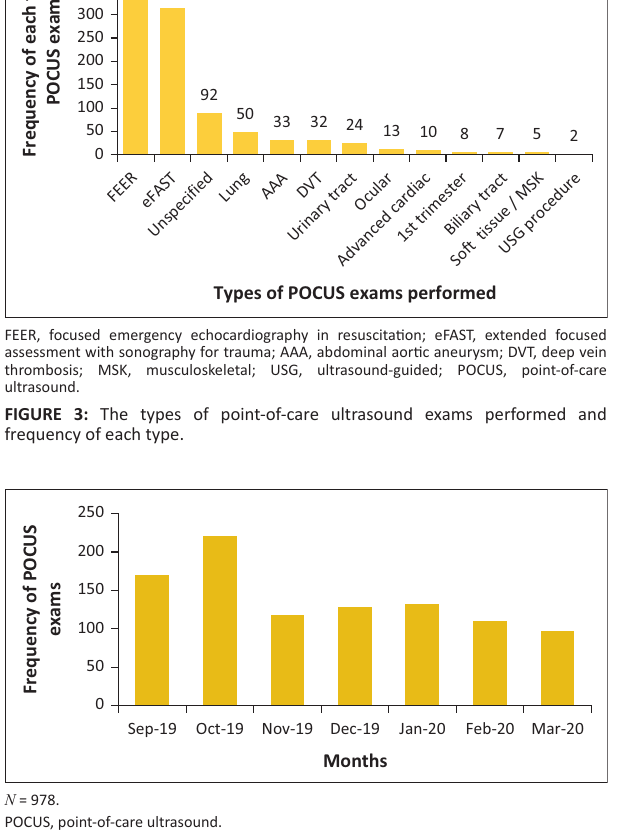
FIGURE 4: Frequency of point-of-care ultrasound exams performed per month.